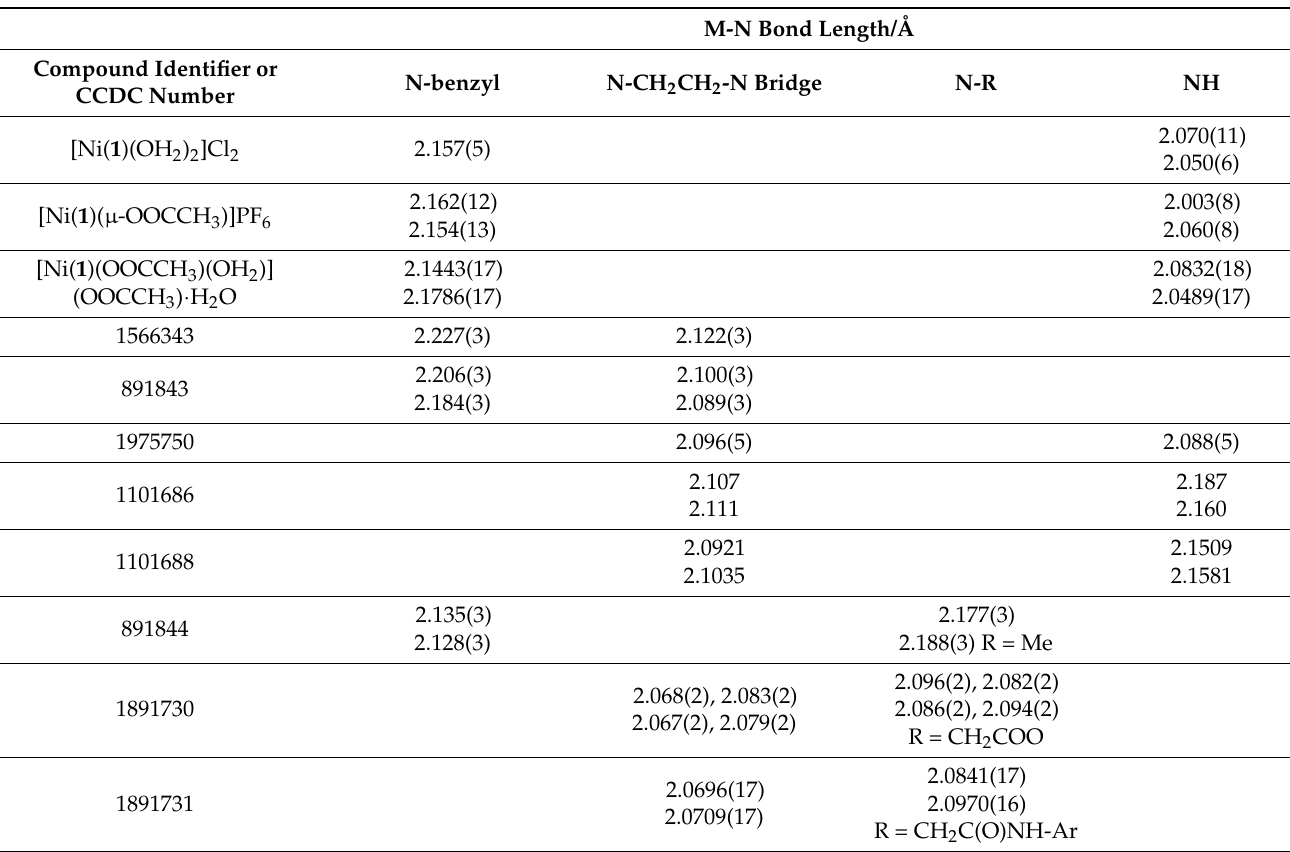
Table 3. N-M bond lengths (Å ) for unbridged cyclen Ni 2+ complexes for comparison. Identification of the complexes is given either by formula for complexes from this work or CCDC identifier.